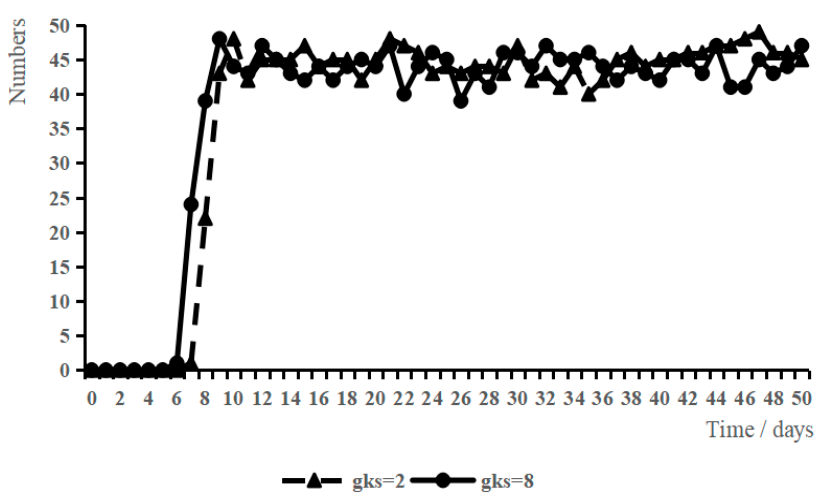
Figure 4. Effect of GKS on WSB.